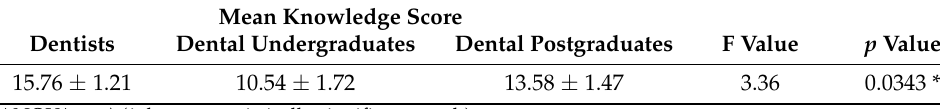
Table 2. Knowledge Scores of dentists, dental undergraduates, and postgraduates.